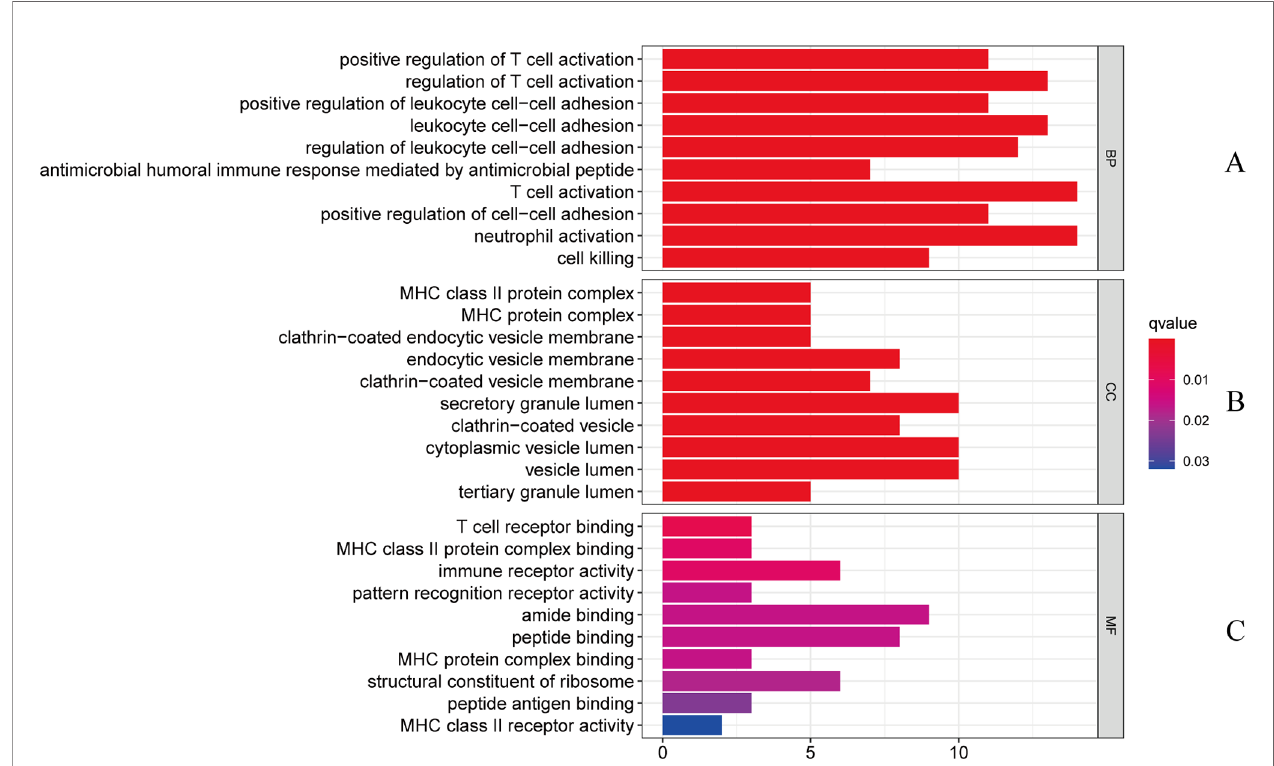
FIGURE 3 | The bar graphs of the ontological analysis of the common DEGs between COVID-19 and RA: (A) biological processes; (B) cellular components; and (C) molecular